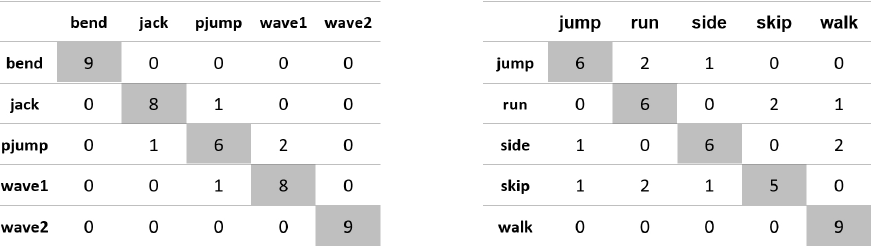
Figure A7. Confusion matrices for the experiment using the ‘lower-occlusion’ database, longerMBR and Euclidean distance.